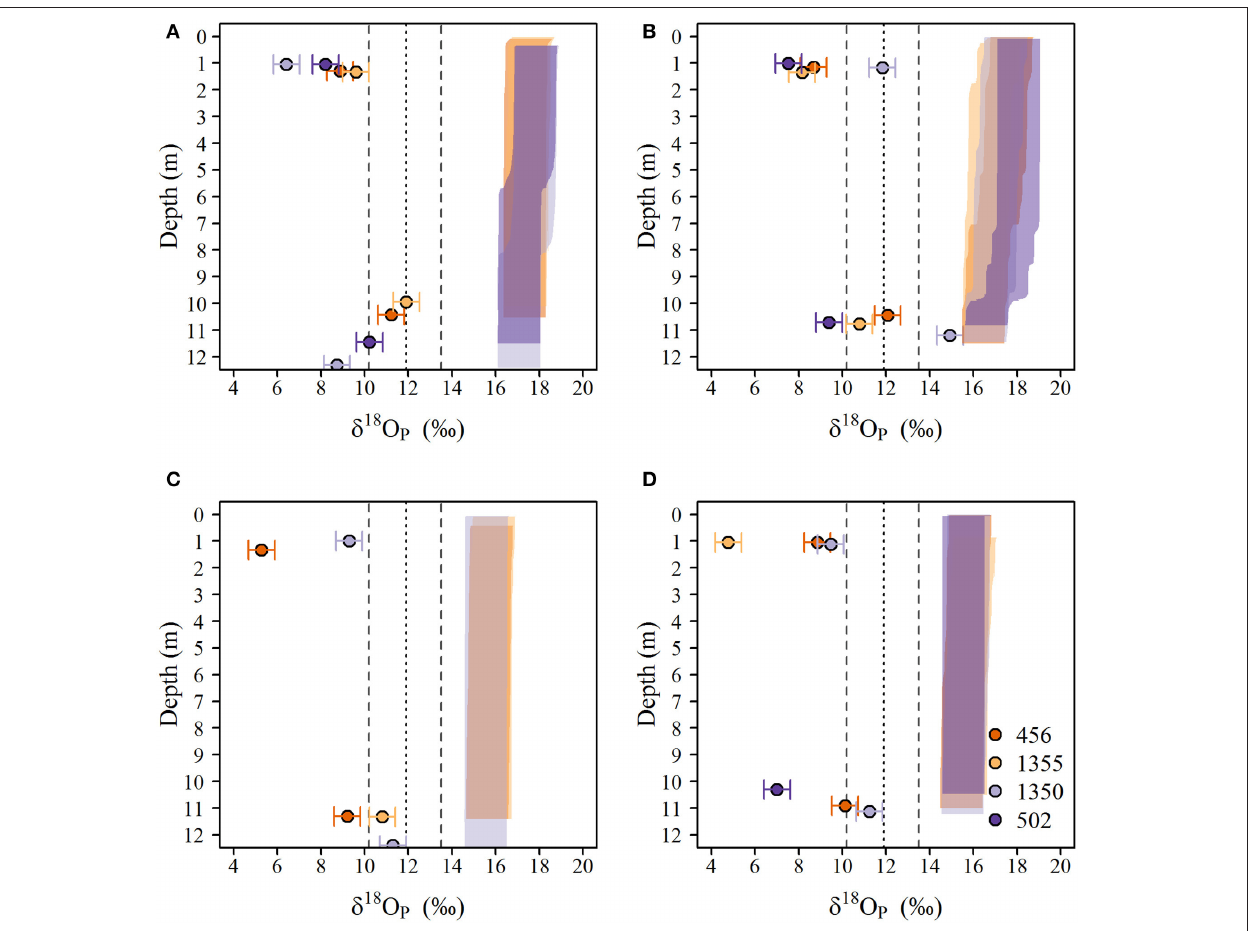
FIGURE 7 | Vertical distribution of δ 18 O P (circles) and calculated equilibrium δ 18 O P_EQ ) (shaded polygons) in the water column at the 10m depth sites in eastern lake Erie during (A) late-May to early June, (B) June, (C) July, and (D) August of 2014. The equilibrium window was determined by interpolating δ 18 O w as function of depth and calculating the range of δ 18 O P_EQ using the temperatures derived from vertical profiles and the equation Chang and Blake (2015) for the minimum and maximum δ 18 O w observed over the study period. The dotted (dashed) vertical line(s) represent the average (range) δ 18 O P_DM measured in laboratory